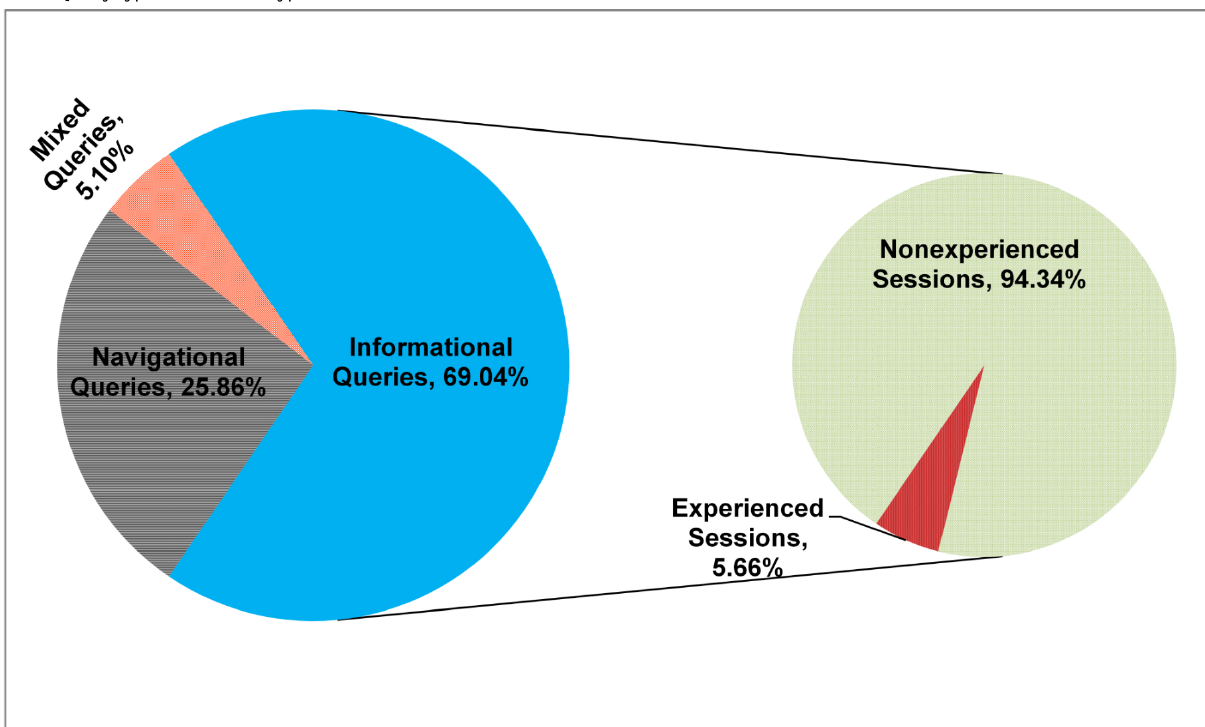
Figure 4. Query types and session types.